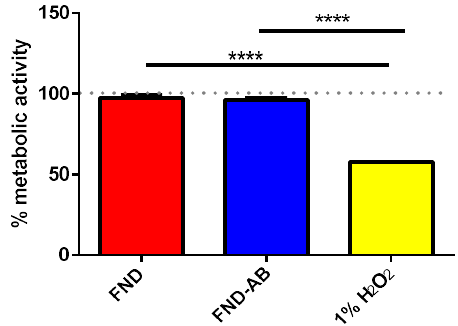
Figure 3. 3-(4,5-dymethylthiazol-2-yl)-2,5-dyphenyltetrazolium bromide (MTT) assay for analyzing metabolic activity of yeast cells. Yeasts without any treatment were used as a comparison (grey dots)